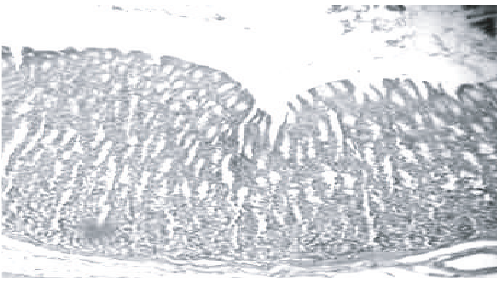
Figure 1: Normal histological structure of rat gastric mucosa.